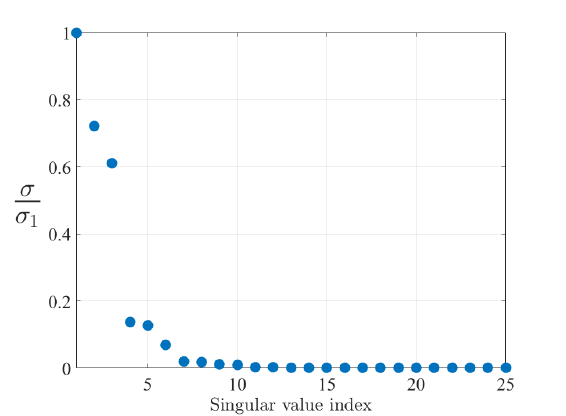
Figure 11. Normalized singular values of the Principal Component Analysis (PCA) of the training